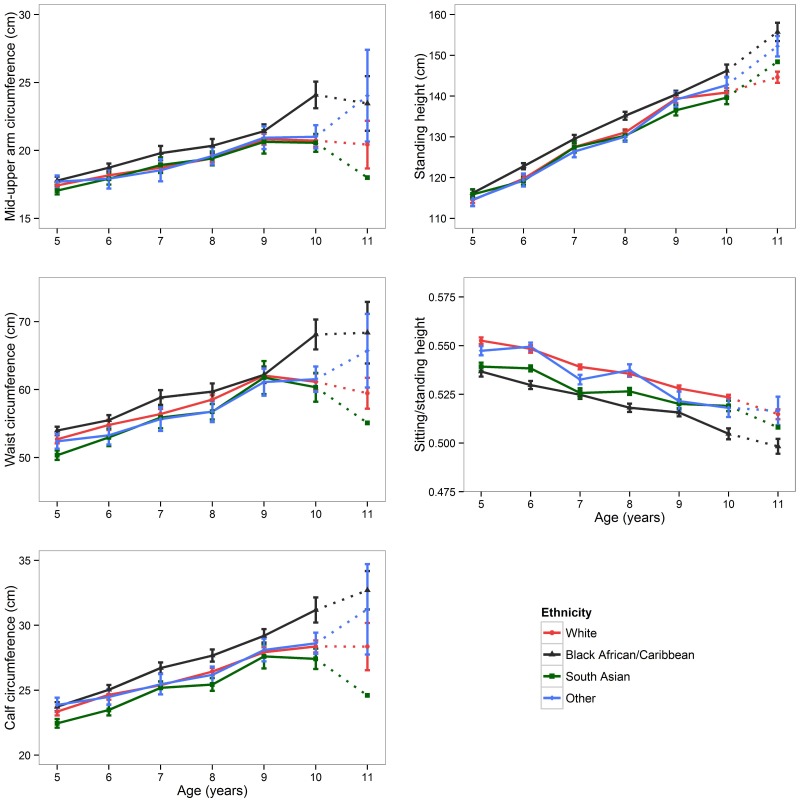
Ethnic differences in anthropometric measurements in boys.Dots represent mean values, error bars represent standard error of the mean. Black African/Caribbean boys generally had higher mean values of all circumferences and standing height, but lower sitting/standing height ratio, at each age group as compared to White and South Asian children. An increasing trend for ethnic differences in body circumferences is evident, especially after 9 years of age. Despite its heterogeneity, the ‘Other’ group tend to track White and South Asian group more closely than Black African/Caribbean group. Similar pattern was observed in girls (Figure S3). Due to relatively small sample size >10 years old (n = 12) the estimates may be biased therefore the trend lines from 10 to 11 years old were replaced by dotted lines.